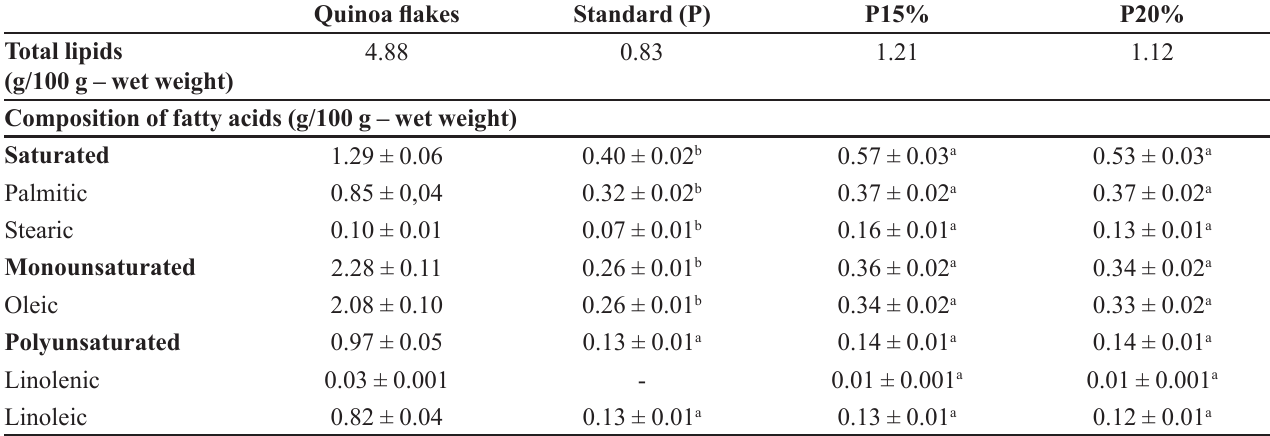
TABLE III - Lipid composition of quinoa flakes and bread made with and without pseudocereal